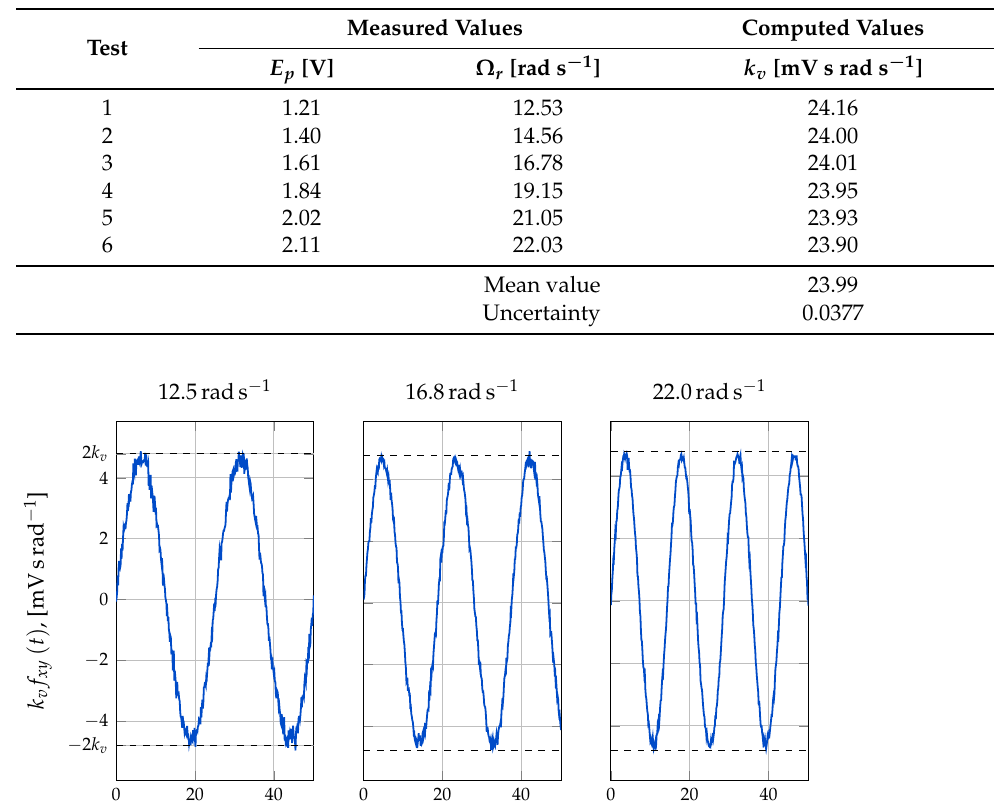
Table 2. Results for the back-emf constant estimation tests.